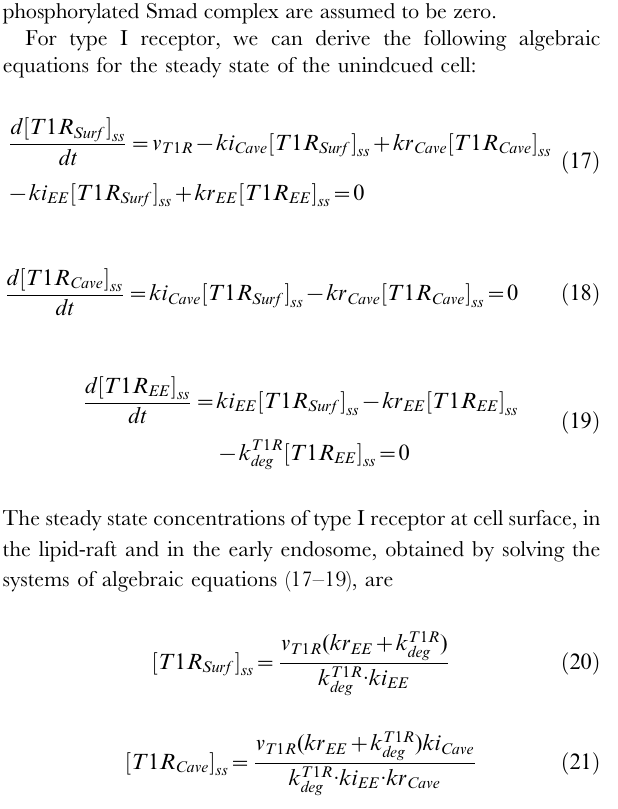
N Rate constant of receptor constitutive degradation : Pervious experimental data indicate that the type II receptor